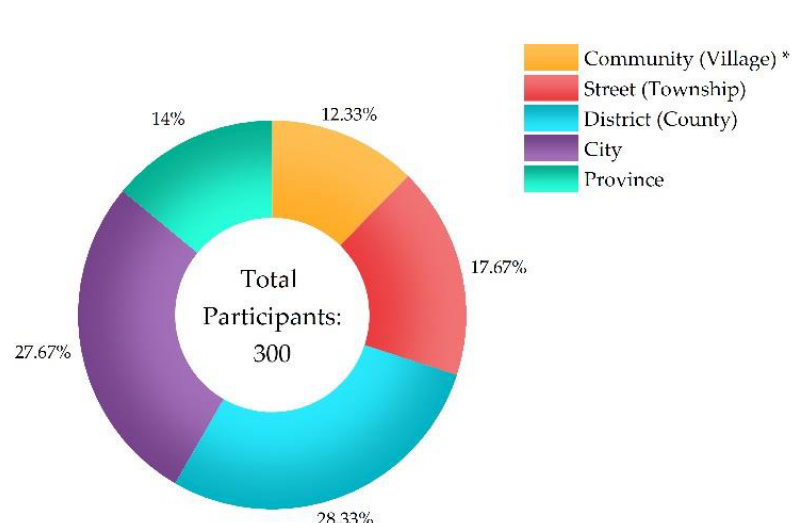
Figure 5. Level of education.